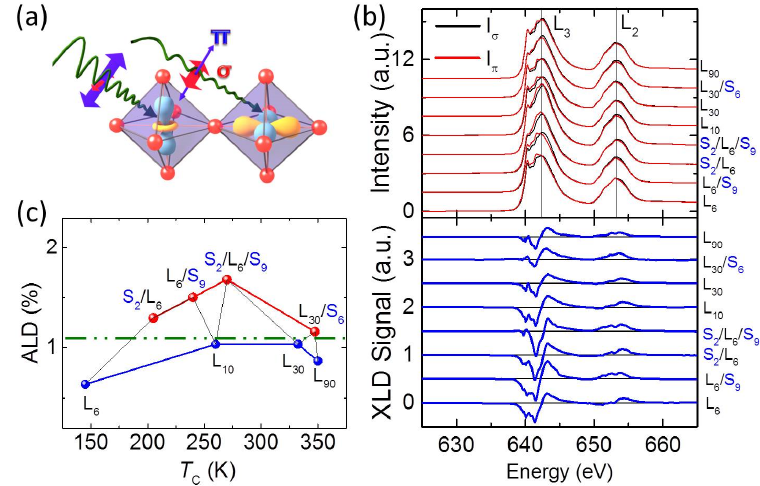
Figure 9. ( a ), Sketch of the X-ray absorption measurement of 3z 2 -r 2 and x 2 -y 2 orbital occupations by π- and σ-polarized X-rays, respectively. ( b ), Polarized X-ray absorption (XAS) of the L 2,3 edge (top panel) and the corresponding linear dichroism (bottom panel) of different LSMO films with/without the STO buffer/capping layer. ( c ), Integrated linear dichroism from 649–659 eV normalized by the (I σ + I π ) for LSMO films, ALD = (I σ − I π )/(I σ + I π ) × 100%. All X-ray linear dichroism (XLDs) were measured at 300